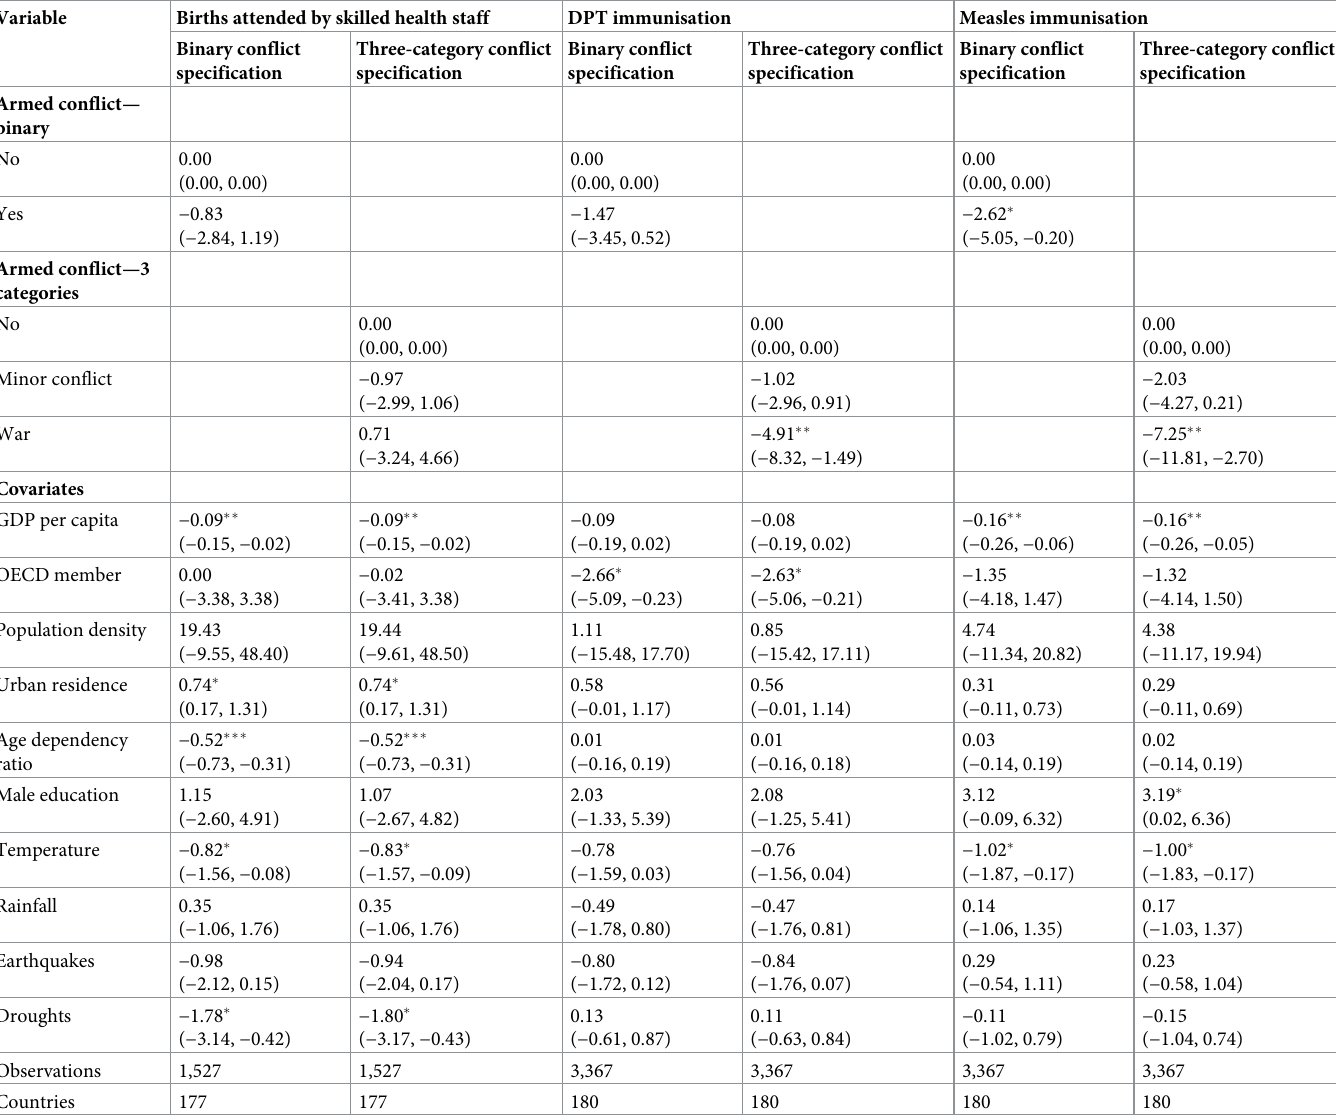
Table 3. AU : IeditedthecolumnheadsinTable 3 asinTable 2 : Pleasecheck : The association between armed conflict and maternal and child health indicators (adjusted beta coefficients, 95% confidence